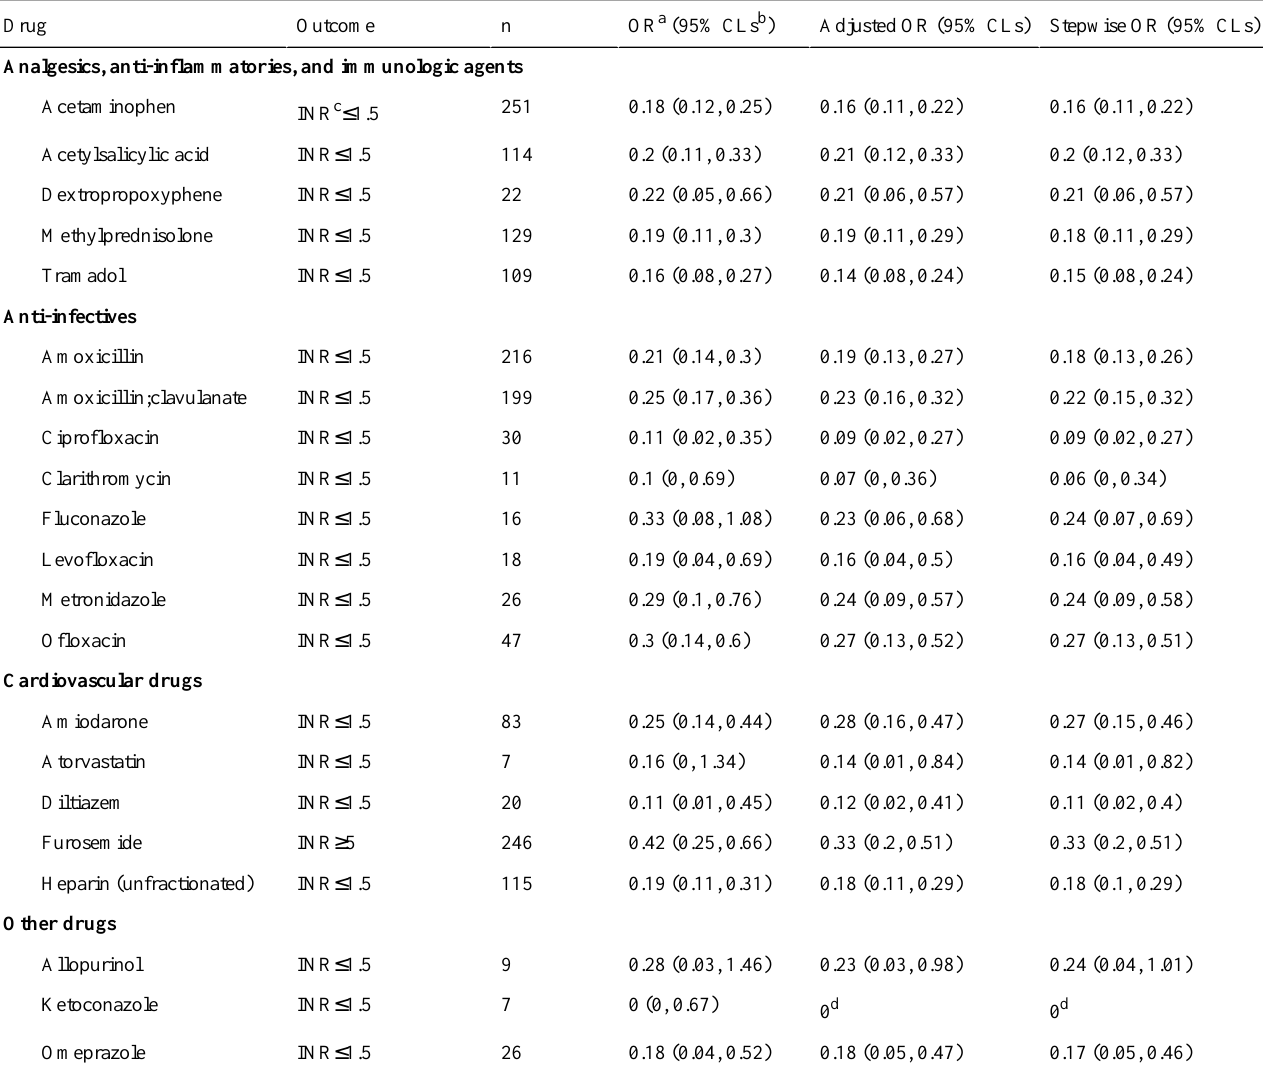
Table 2. Drugs interacting with VKAs upon discontinuation and that had at least one significant OR (in all cases, 4047 stays are analyzed).